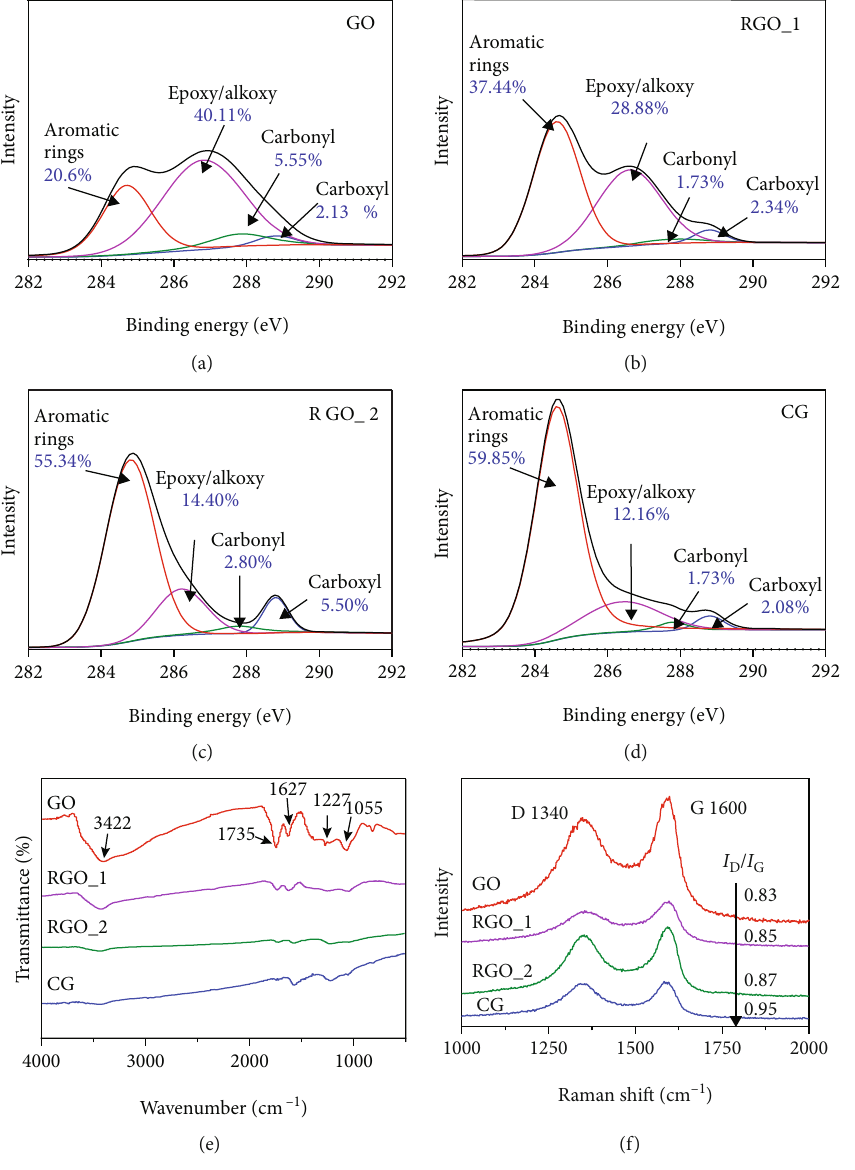
Figure 1: X-ray photoelectron spectroscopy (XPS) curve fi t of C1s spectra of GMs (a – d); Fourier transform infrared spectra (FTIR) of GMs (e); Raman spectra of GMs